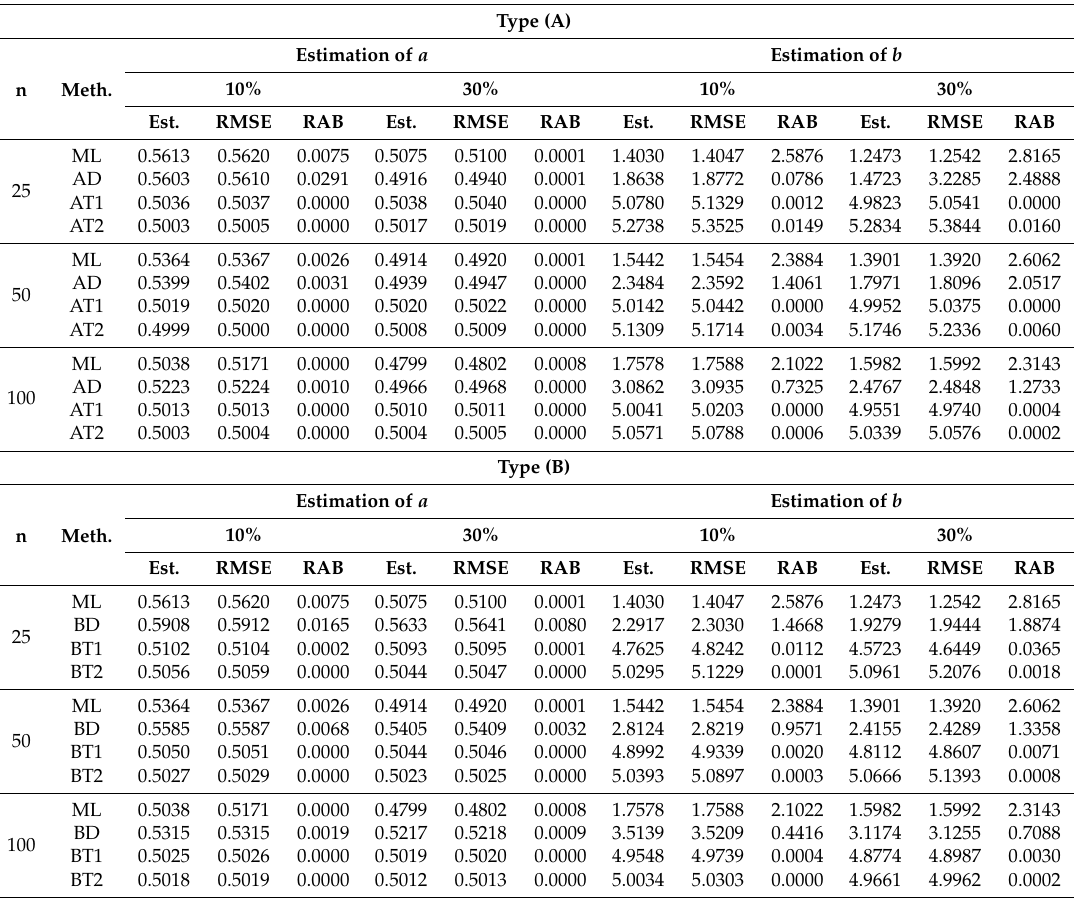
Table 1. The estimates, root of mean square error (RMSE) and relative absolute biases (RABs) for two parameters of the Weibull distribution using TL-moments, direct L-moments, and ML method based on left censoring ( a = 0.5 and b = 5) in the presence of